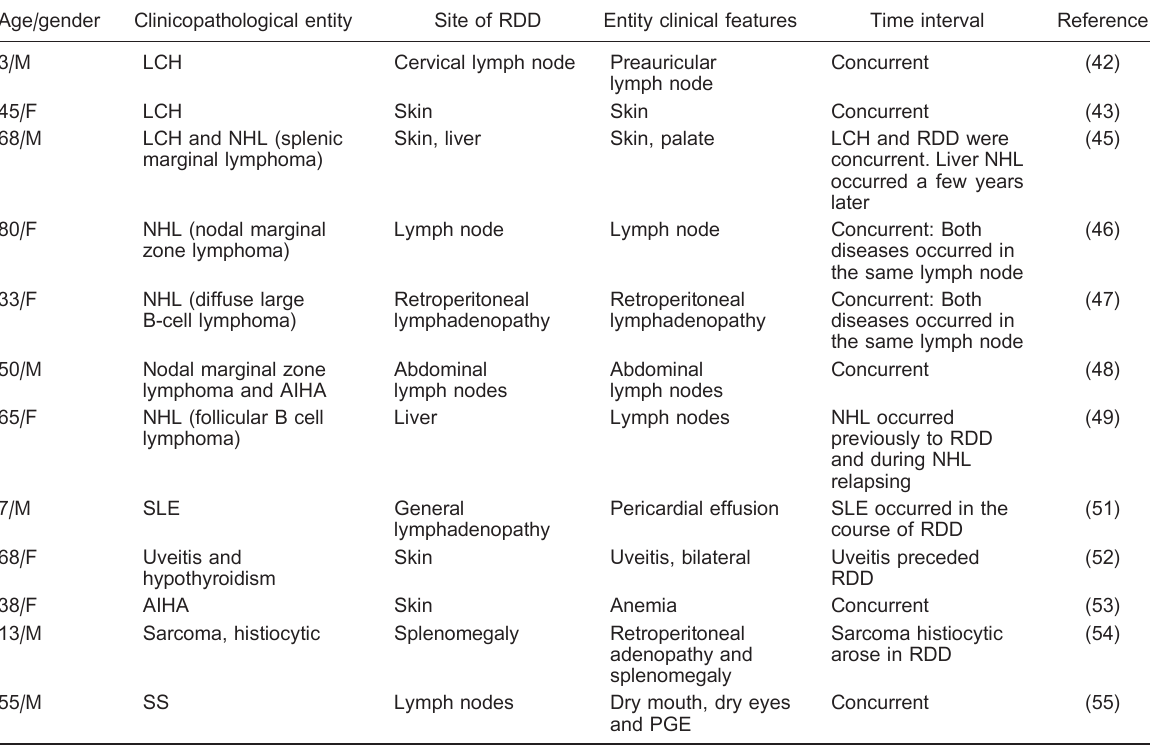
Table 3. Association of Rosai-Dorfman disease with other